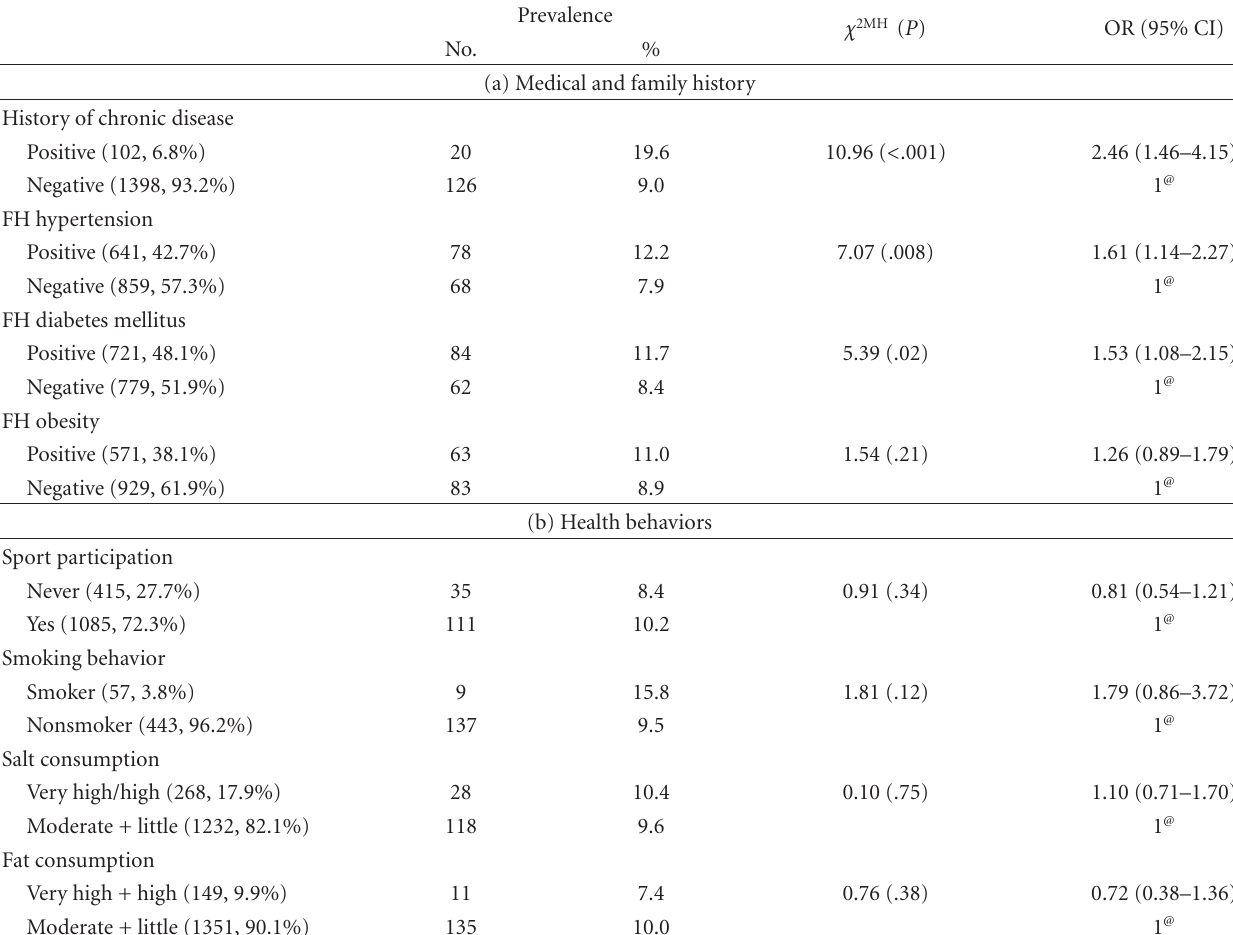
Table 3: Prevalence of elevated blood pressure among study sample of school adolescents in relation to medical and family history of chronic diseases/conditions and health